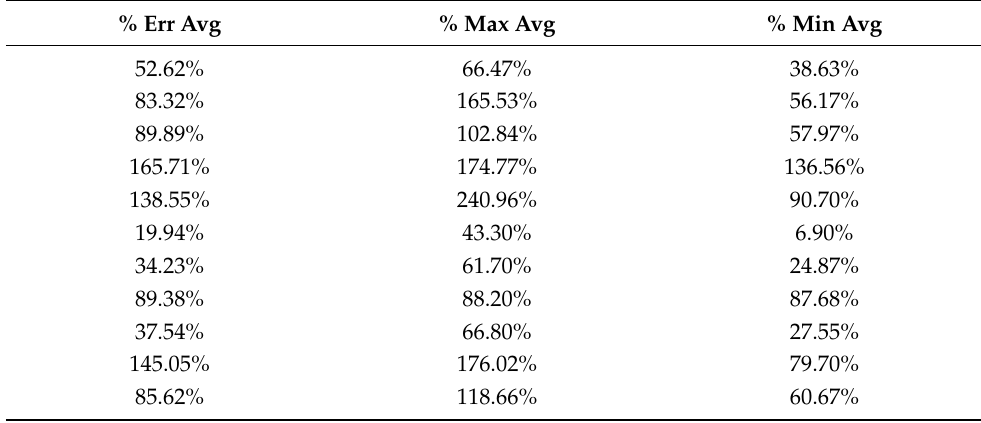
Table A197. Set 3, trials 21–30 data (average actual PR values).